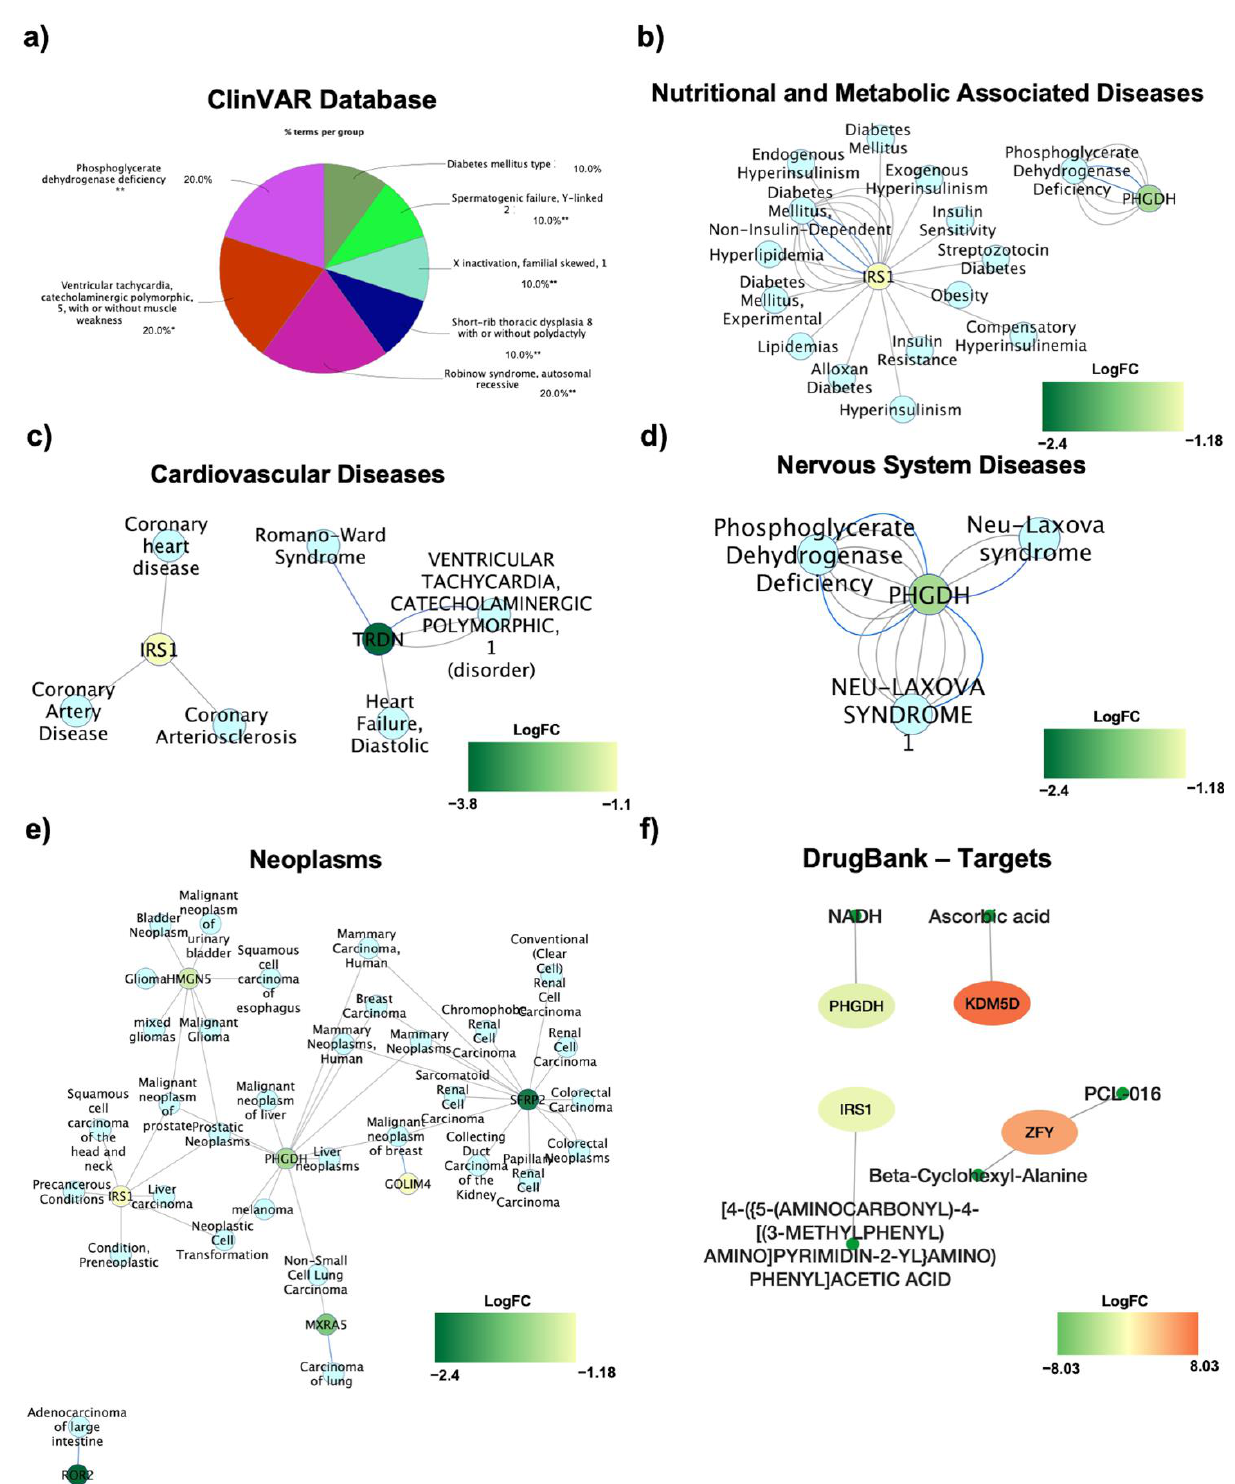
Figure 5. Susceptibility to co-morbidities development in OBM vs. OBF: ( a ) ClinVar database disease implications are reported as a ClueGO graph, where each pie segment refers to the % of terms present per group; * p < 0.05 and ** p < 0.01. The DisGENET database was used to identify the DE RNAs correlation with ( b ) Nutritional and Metabolic Associated Diseases, ( c ) Cardiovascular Diseases, ( d ) Nervous System Diseases, and ( e ) Neoplasms. ( f ) The NDEx Cytoscape plugin through DrugBank database allowed the identification of potential drug targets. The DE RNAs are color-filled, and the color indicates the respective log 2 FC.